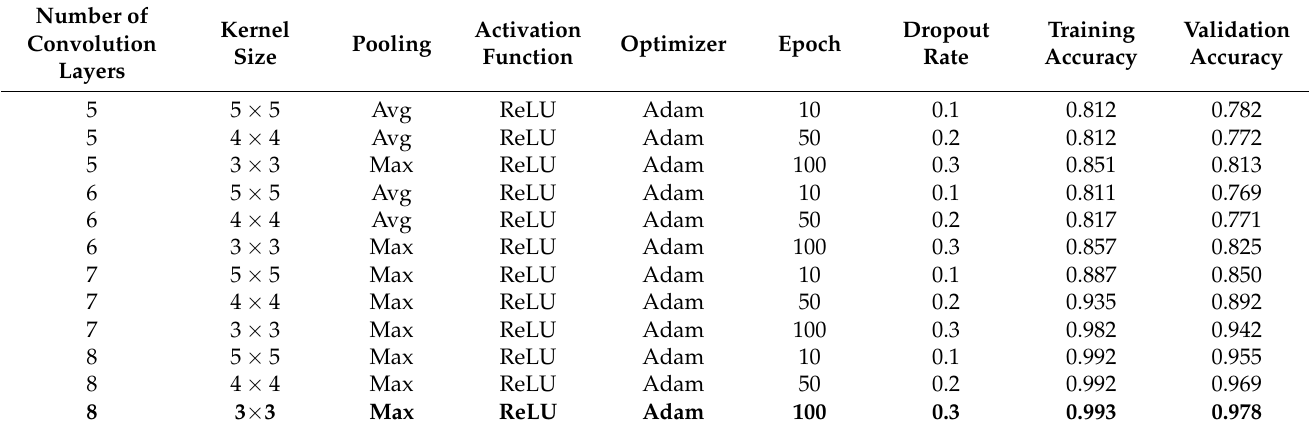
Table 4. Performance of proposed CNN under different